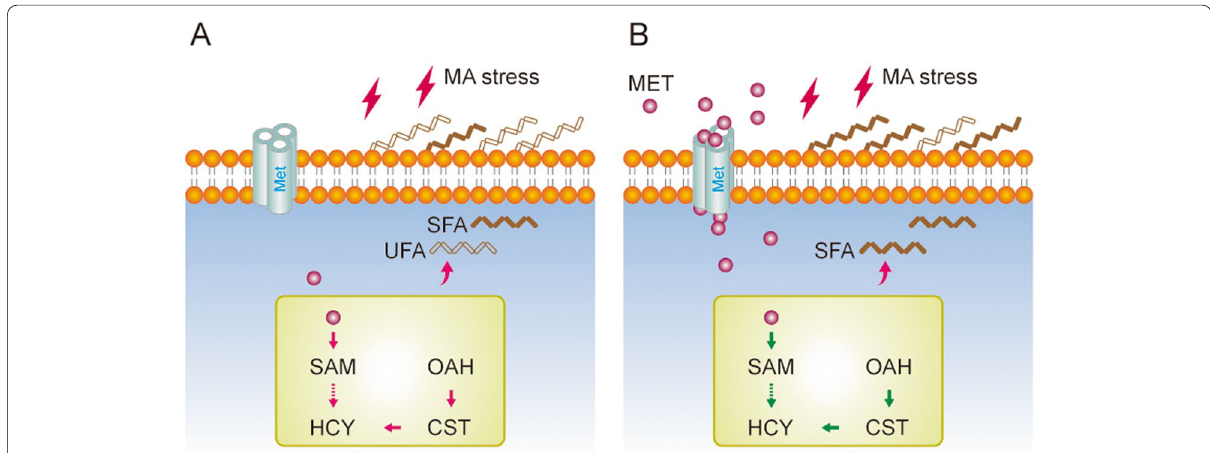
Fig. 6 A regulatory mechanism of L. plantarum responding to acid stress without ( A ) and with methionine supplementation ( B ). Met indicates the methionine transporter in L. plantarum XJ25. MA, malic acid; SFA, saturated fatty acid; UFA, unsaturated fatty acid; MET, methionine; SAM, S -adenosylmethionine; HCY, homocysteine; CST, cystathionine; OAH, O -acetylhomoserine. Pink and green arrows indicate enhanced and decreased fluxes, respectively. Solid line arrows represent direct effects, dashed and flexual line arrows represent indirect